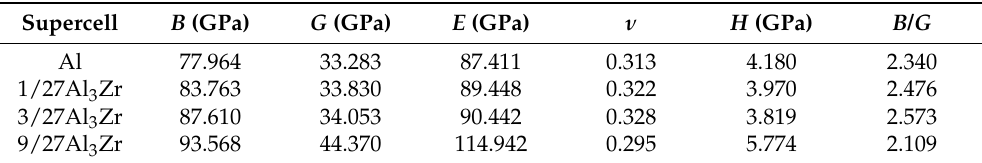
Table 2. The calculated bulk modulus B , shear modulus G , Young’s modulus E , Poisson’s ratio ν , hardness H and Pugh ratio B / G .